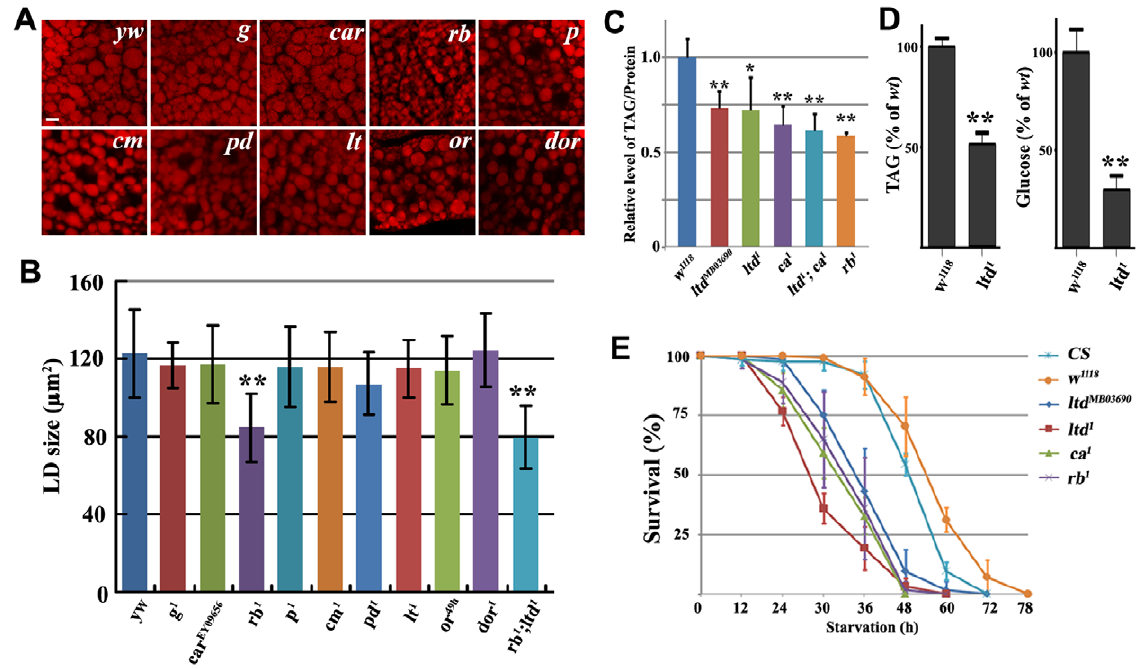
Figure 3. ltd , ca and rb affect lipid storage. (A) Lipid droplets in different eye pigment granule biogenesis mutants. Nile red staining of lipid droplets in wandering stage third instar larval fat body cells. rb mutants have small lipid droplets. Scale bar: 10 m m. (B) Quantification of lipid droplet size in different eye pigment granule biogenesis mutants and rb;ltd double mutants. The error bars represent the standard deviation. **: P , 0.001. (C) The level of TAG is reduced in ltd , ca and rb mutant larvae. The error bars represent the standard deviation. *: P , 0.01; **: P , 0.001. (D) The level of TAG and glucose are reduced in ltd 1 mutant adults. **: P , 0.001. (E) Survival curve of adult flies under starvation. ltd , ca and rb mutants are sensitive to starvation.